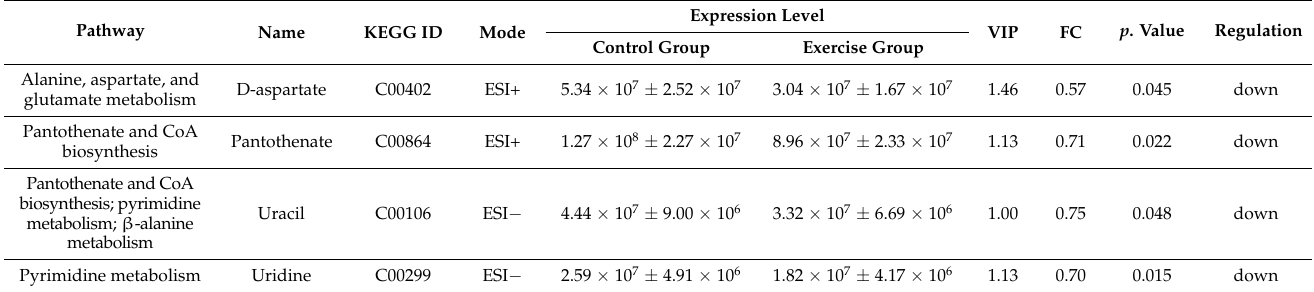
Figure 5. Bubble plots for metabolic pathway enrichment analysis of the differential metabolites (DMs) in the positive electron spray ionization (ESI+) and negative electron spray ionization (ESI − ) modes ( A , B ). The y -axis is the enriched metabolic pathway, and the x -axis is the enrichment factor (RichFactor). The larger the value of RichFactor, the greater the proportion of DMs annotated to the pathway. The size of dots represents the number of DMs annotated to a given pathway. Table 1. Differential metabolites enriched in the four identified